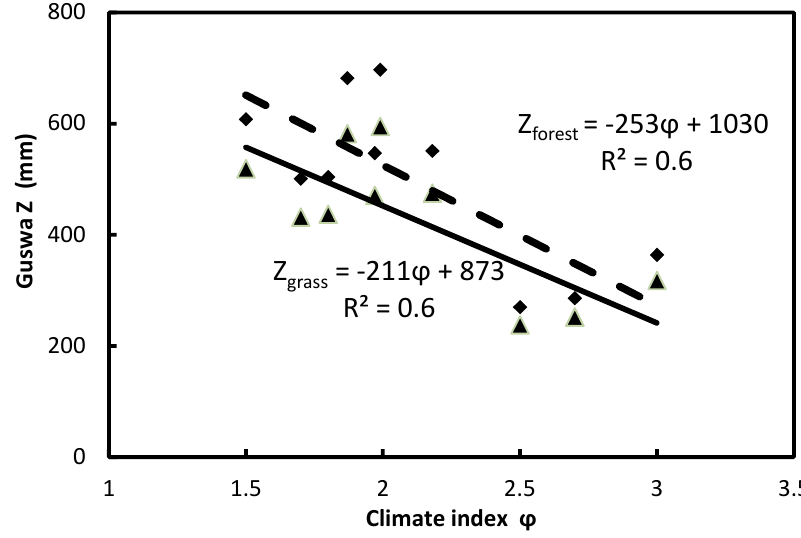
Figure 3. Z ( ♦ ) and Z ( ▲ ) calculated from the Guswa model for each catchment forest grass plotted against the climate index ( ϕ = E o